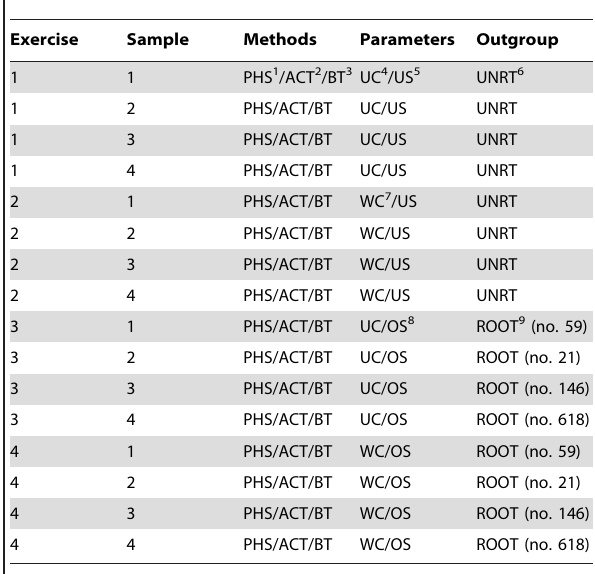
Table 5. Conditions of the four phylogenetic exercises.